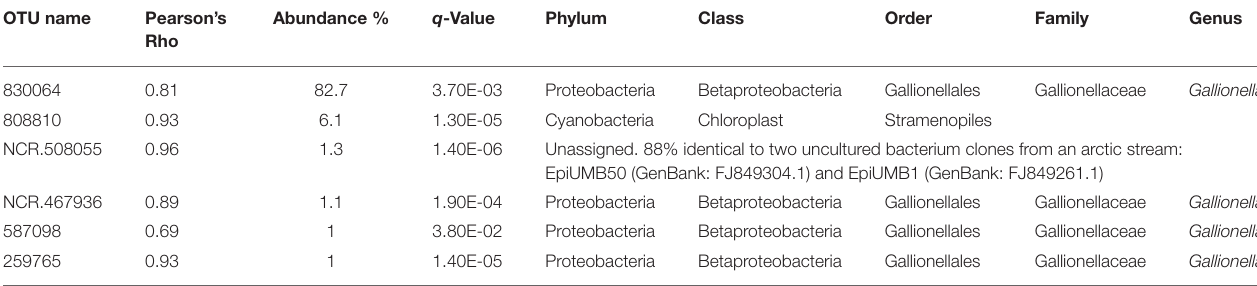
TABLE 3 | OTUs positively correlated with copper concentration are from Gallionellaceae and Stramenopiles .